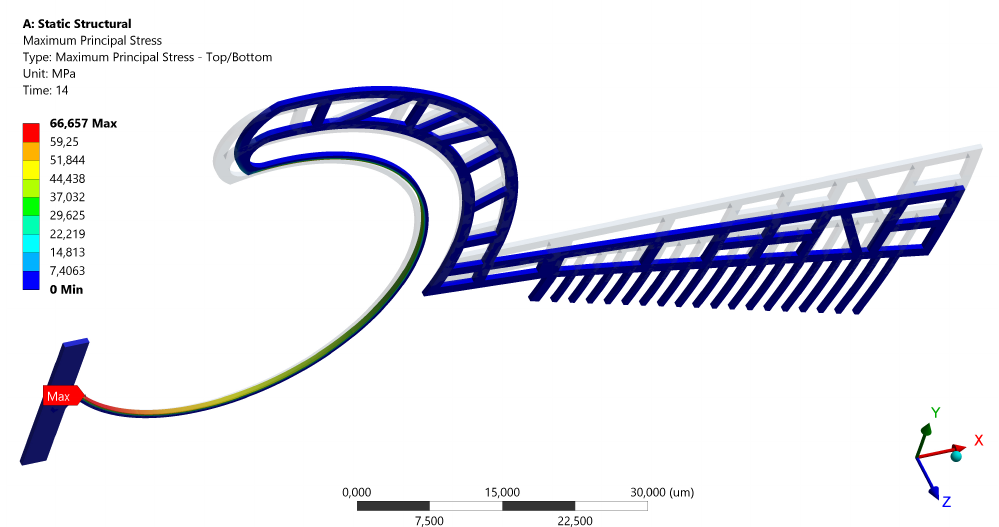
Figure 5. First layout: neutral and deformed configurations, and stress distribution on the